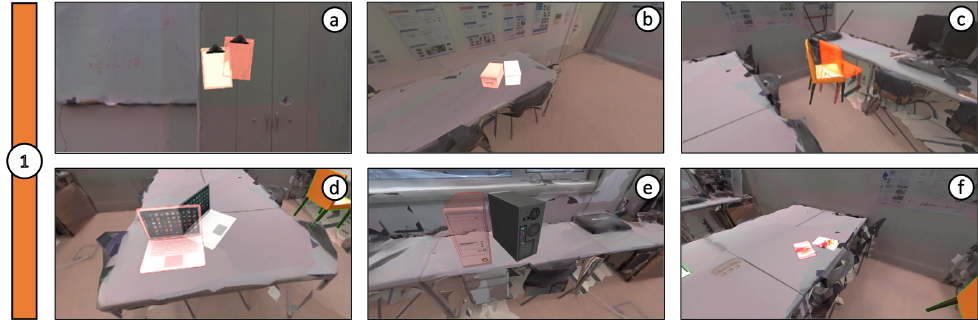
Figure 9. Positioning of 6 virtual objects and their respective target poses (transparent counterpart) using the desktop version: ( a ) notepad; ( b ) cardboard box; ( c ) chair; ( d ) laptop computer; ( e ) desktop; ( f ) book.